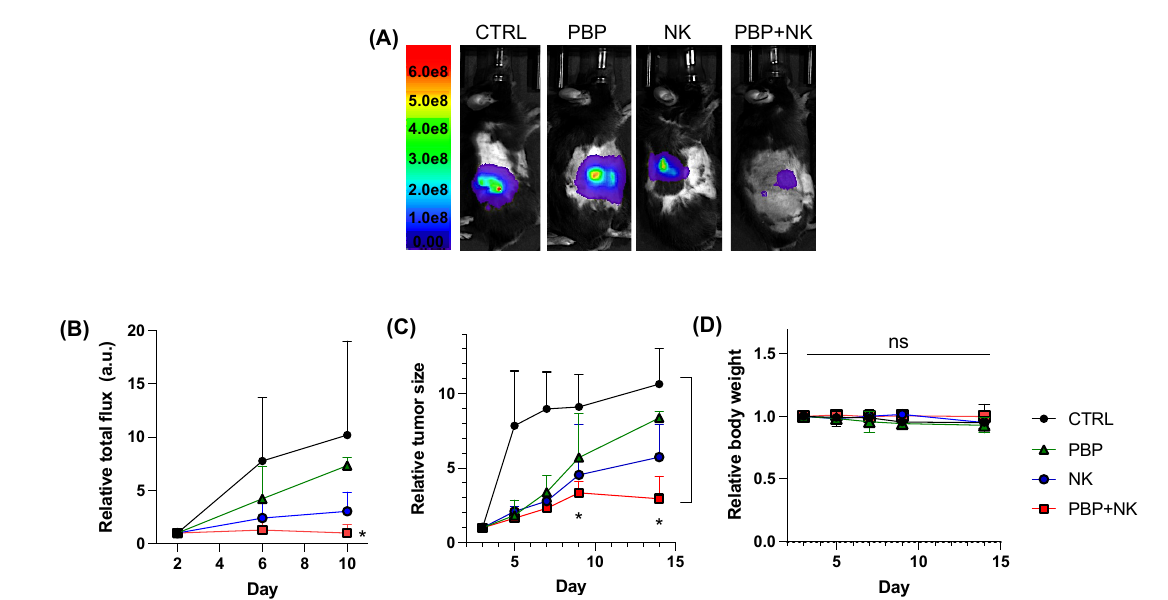
Figure 4. In vivo anti-tumor activity of NK cells and/or PBP. ( A ) In vivo luciferase bioluminescence imaging on day 10. ( B ) Relative luciferase flux. ( C ) Relative tumor size based on manual measurements and ( D ) relative body weight during treatment. Two-way ANOVA, Tukey test, p < 0.05 was conducted for statistical analysis (* p < 0.03, and ns = non-significance); n = 8.